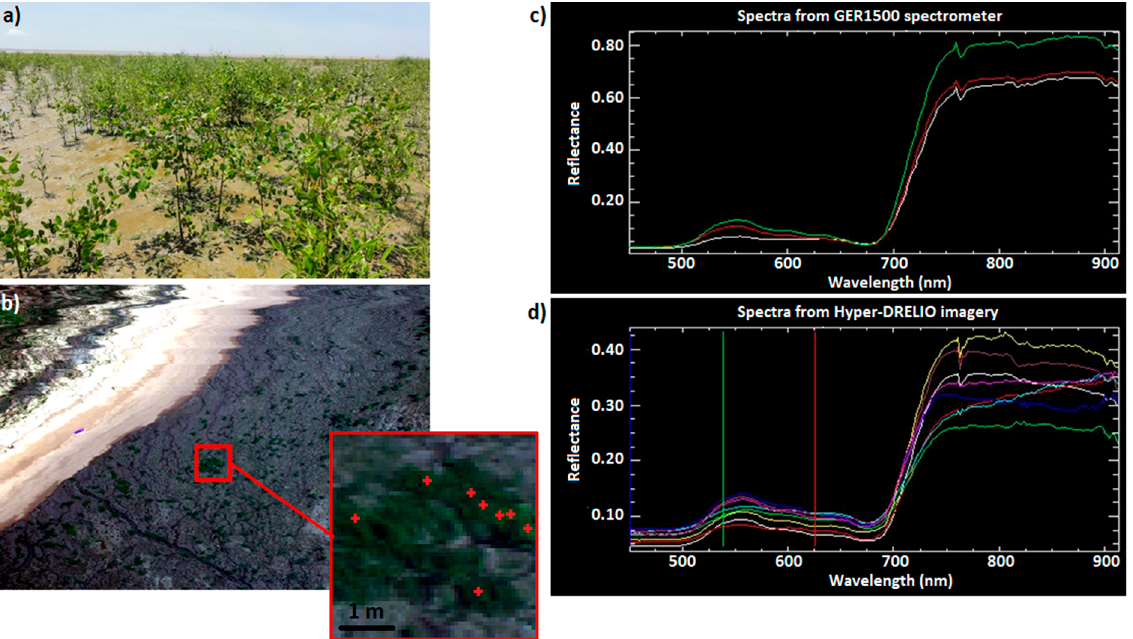
Figure 7. Spectra comparison above the pioneer mangroves. ( a ) Aerial oblique photograph of the pioneer mangroves. ( b ) Mangrove patch on the Hyper-DRELIO image (in natural colours) where the spectra are pointed (red crosses). The image was acquired on 12 September 2018 at 11:08. ( c ) Mangrove spectra measured by GER1500 spectrometer. ( d ) Mangrove spectra extracted from Hyper-DRELIO imagery (mean standard deviation between the reflectance spectra: 0.061).